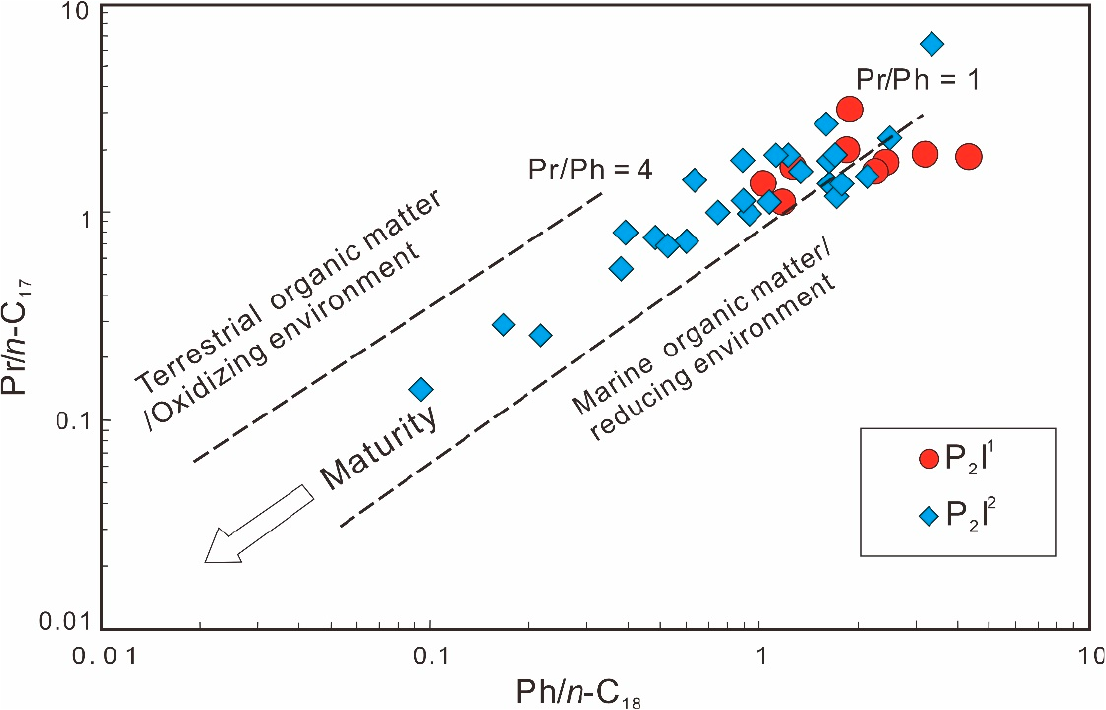
Figure 2. Plot of Pr/ n -C 17 vs. Ph/ n -C 18 showing the depositional environment of the P 2 l source rocks in the Jimsar Depression (modified after Shanmugam, 1985) [27] (terrestrial organic matter/oxidation environment; maturity; marine organic matter/reducing environment).